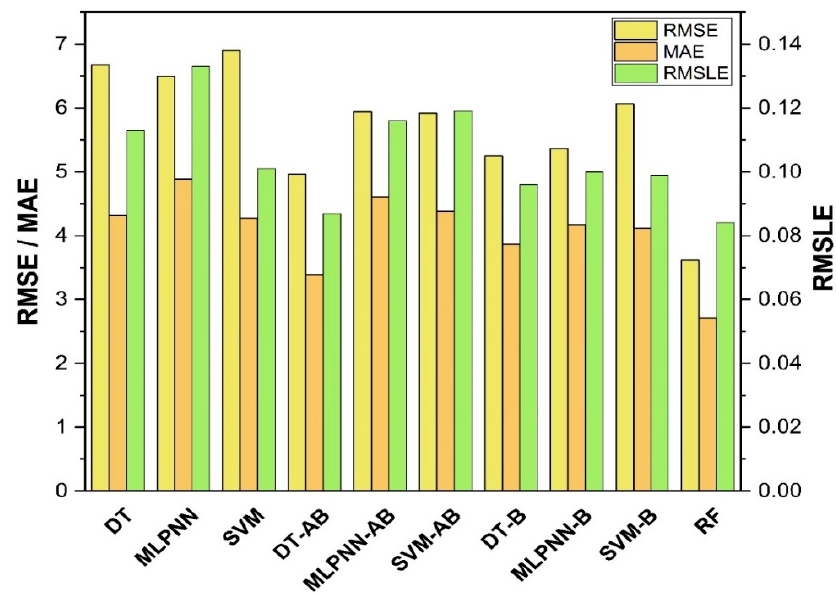
Figure 20. Statistical analysis of compressive strength models .